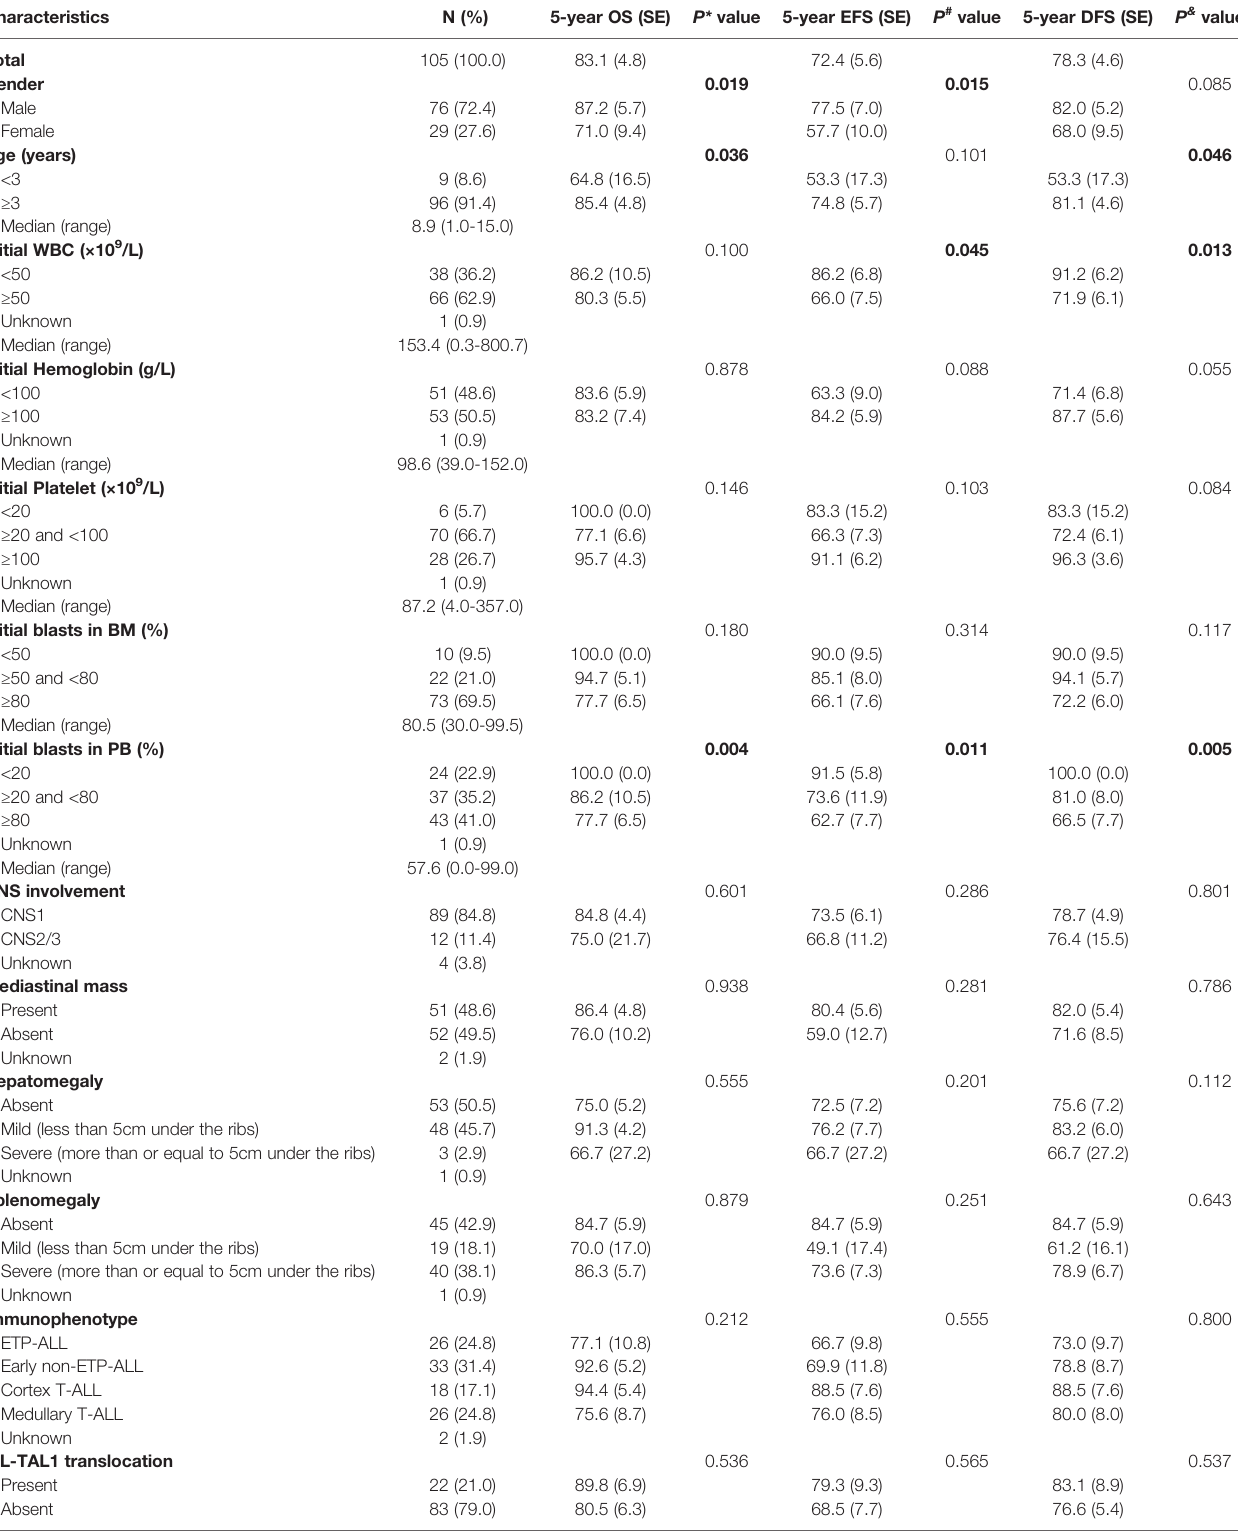
TABLE 1 | The clinical-biological characteristics of 105 children with T-ALL and the comparisons of their survival.